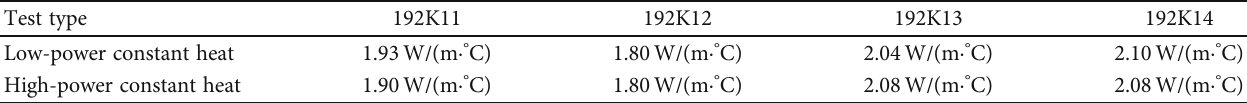
Figure 11: The variation curve of high-power constant heat fl ow heating T Table 2: Average thermal conductivity of rock-soil body under the high- and low-power constant heat fl ux test. Test